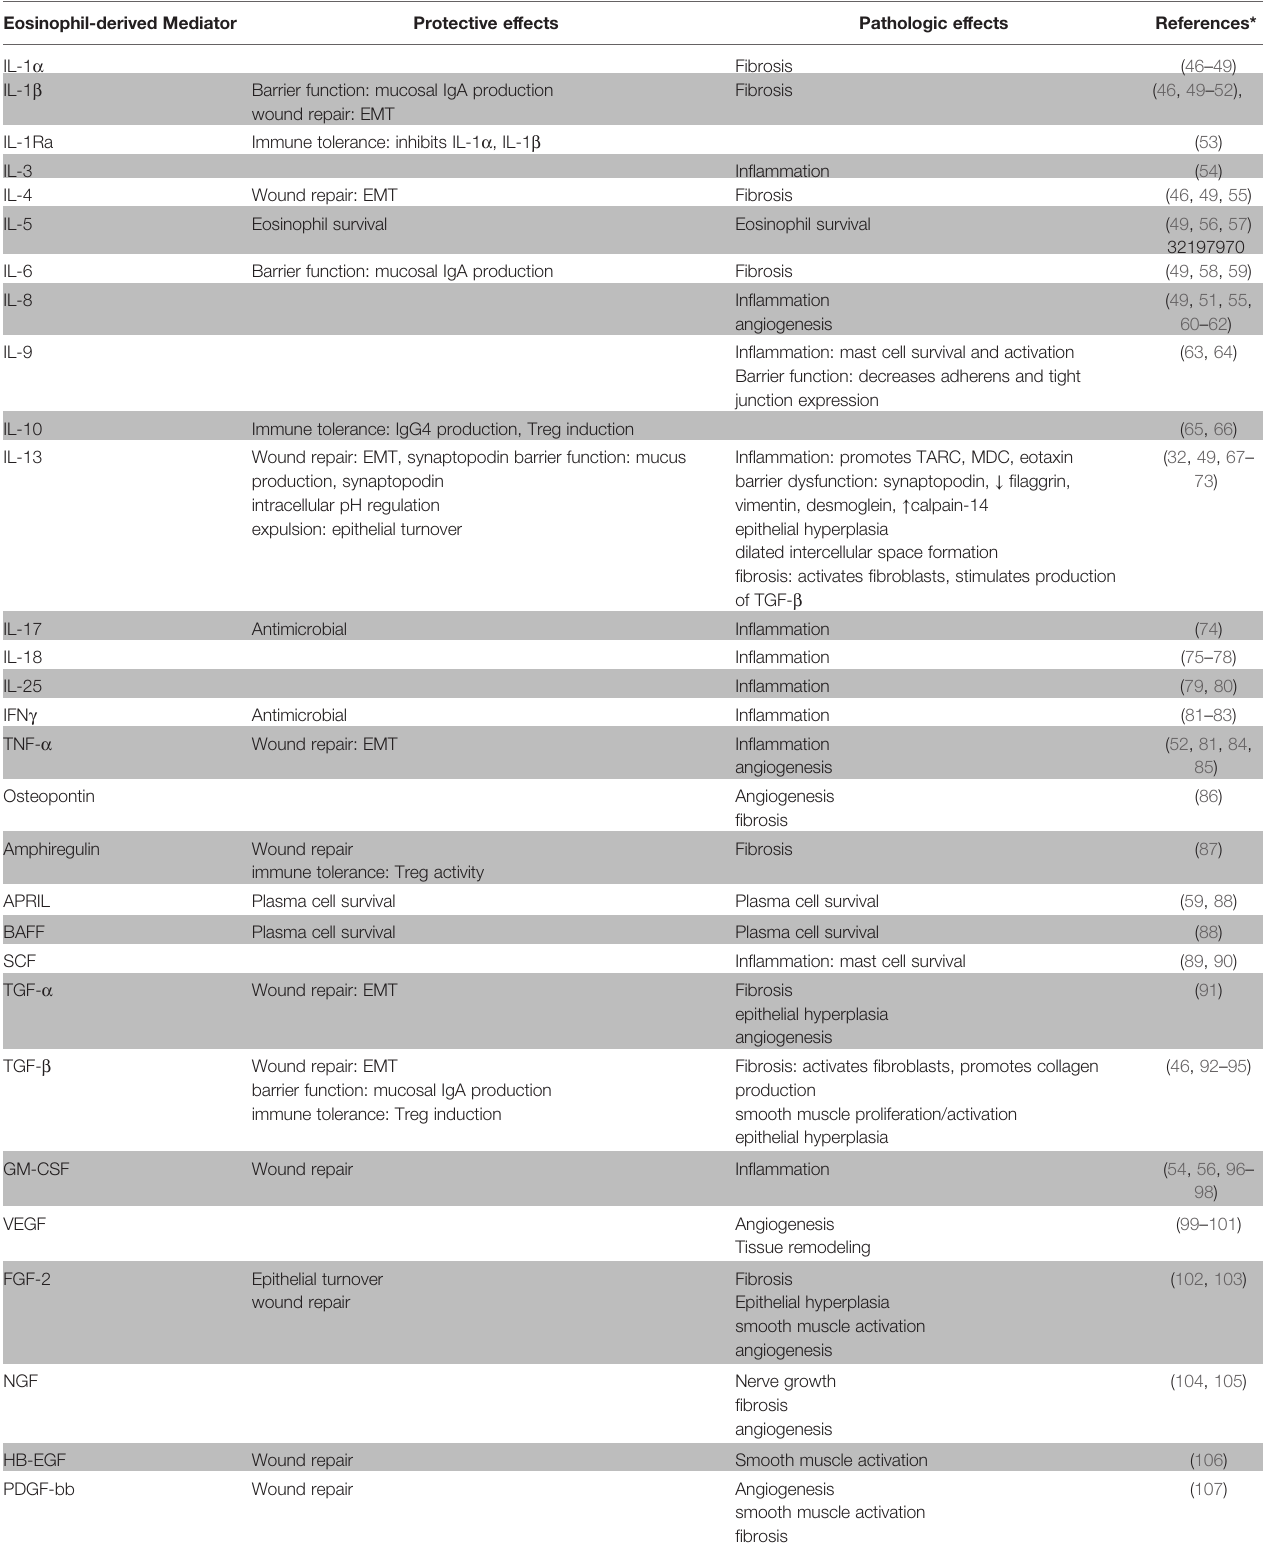
TABLE 1 | Protective and pathologic effects of eosinophil-derived